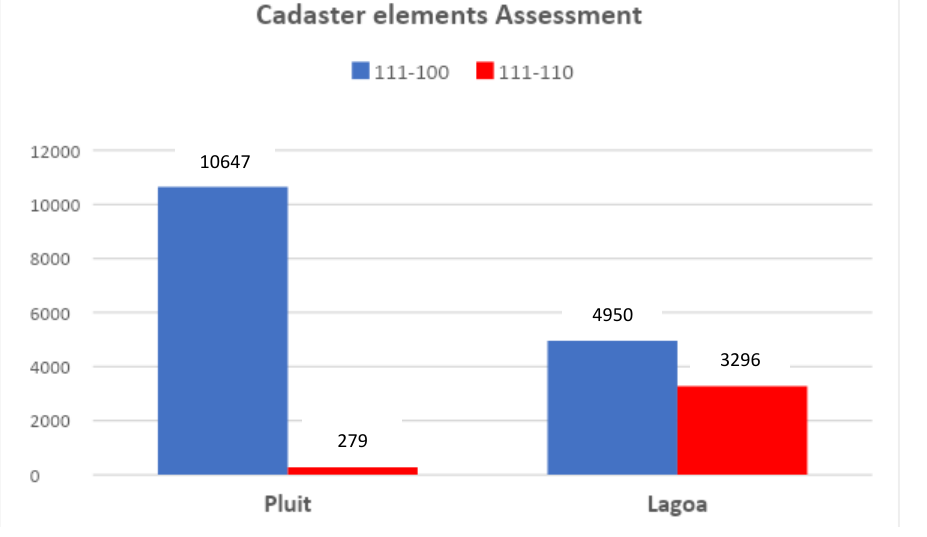
Figure 4. Cadastre typology in Pluit and Lagoa Wards. Table 4. Dataset of spatial cadastre elements in Pluit and Lagoa Wards. Table 5. Dataset of spatial cadastre elements in Pluit and Lagoa